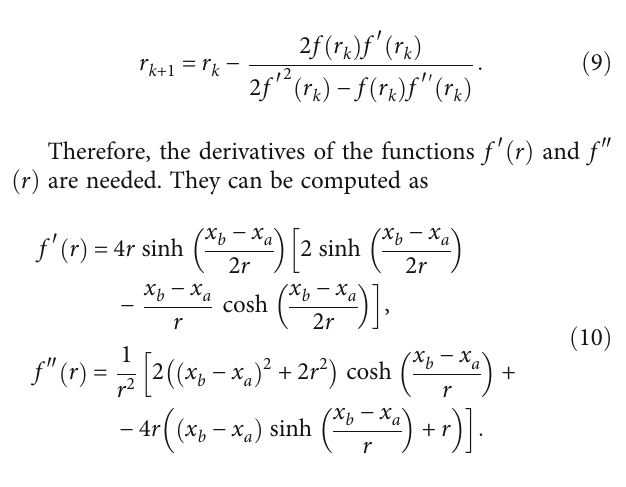
Figure 2: Balance of forces acting on the rope. F forces at the suspension points. They act tangentially along the rope. F G is the weight force which acts in the negative y